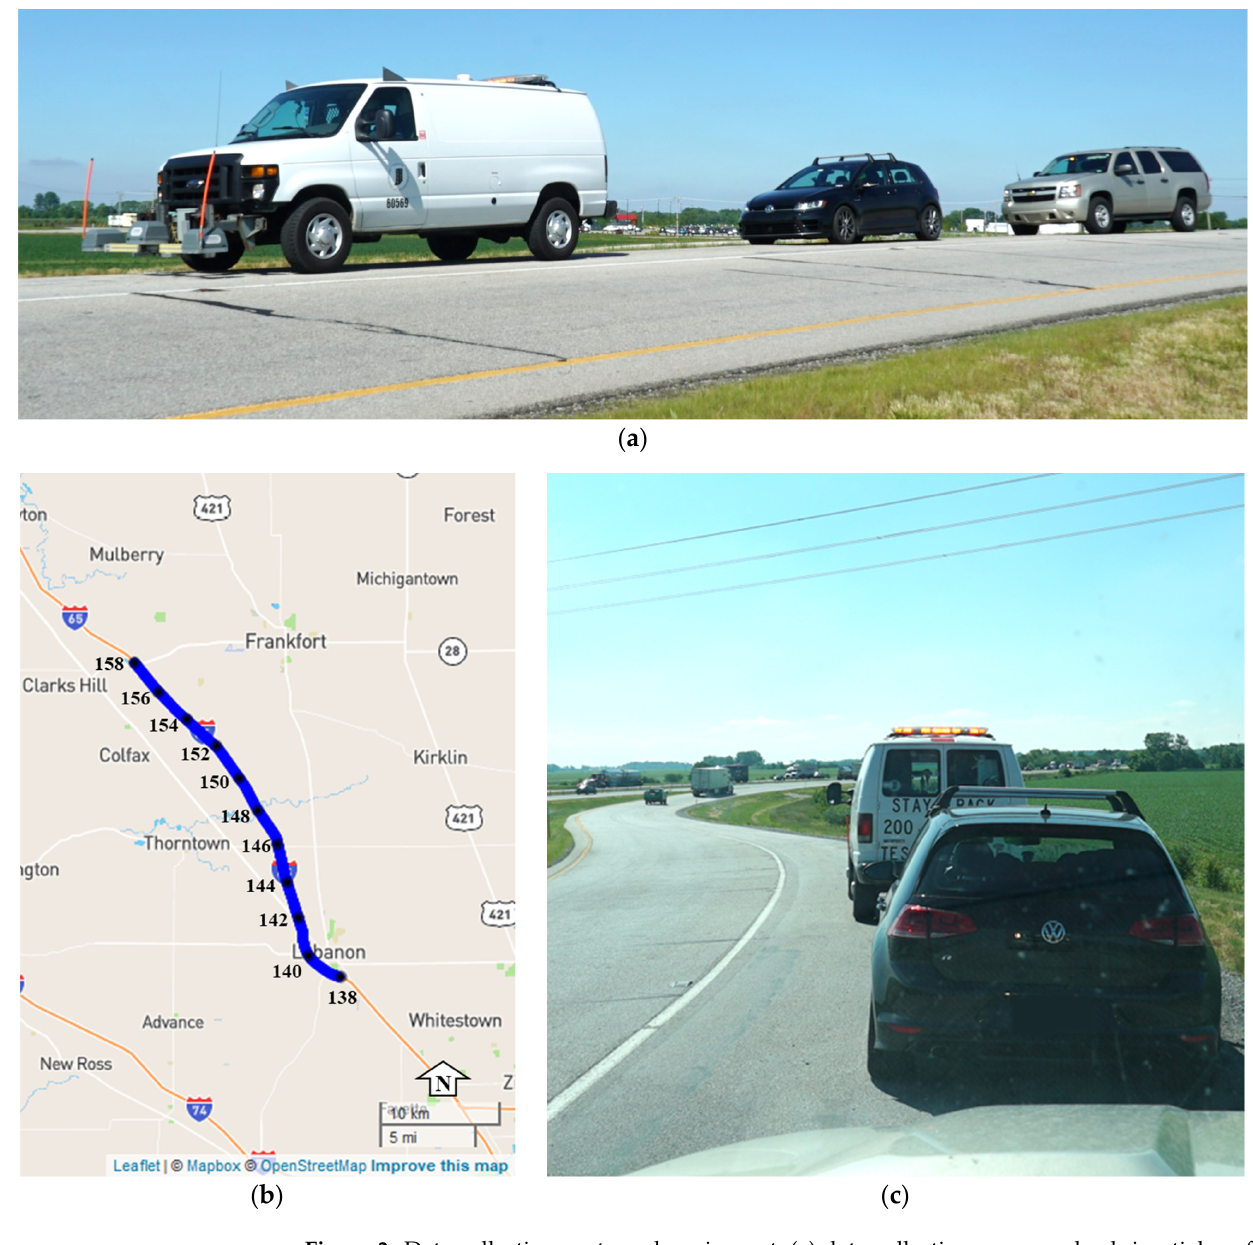
Figure 3. Data collection route and equipment; ( a ) data collection convoy—lead: inertial profiler, second: production vehicle, final: safety vehicle with hazard lights; ( b ) Indiana I-65 from reference marker 138 to 158; ( c ) data collection convoy.